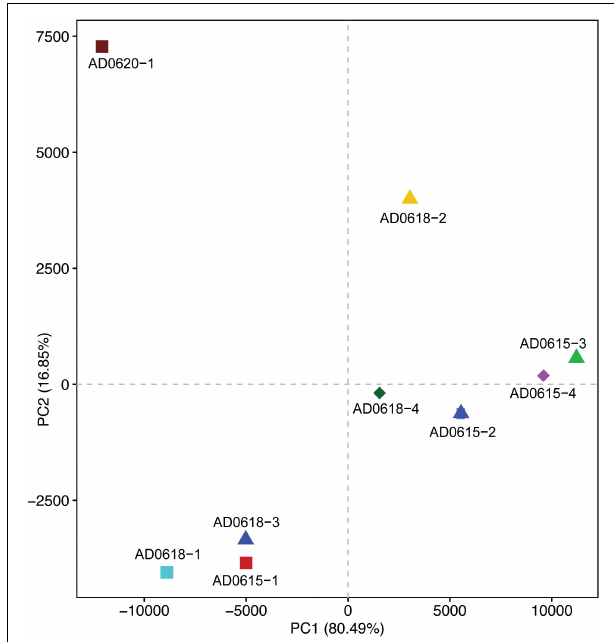
FIGURE 7 | Principal Component Analyses illustrating the similarities and distinction of the functional attributes of the bacterial communities among the nine accessions studied. The shown scatter plot was based on FAPROTAX. Axis1 explained 80.49% and Axis2 explained 16.85% of the variation. Chemoheterotrophy was the main contributor to axis1 besides methanol/methyl and nitrogen processing pathways, which were also main contributors to axis 2 besides fermentation. Scatter plots based on PICRUSt cog and ko analyses showed highly similar results (results not